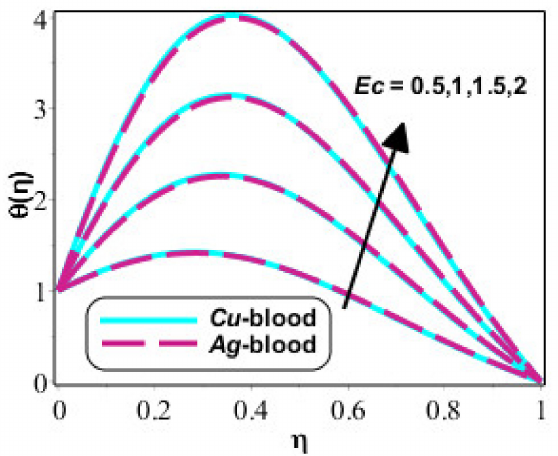
Figure 10. Behaviour of θ ( η ) against Ec when M = 5, Nr = 0.5, φ = 0.1,Pr = 3.9, Y = 0.8, β i = β e = 0.7.